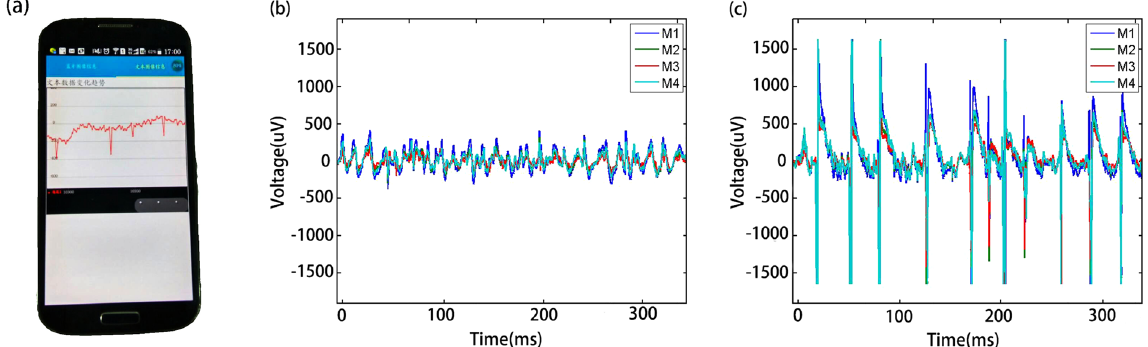
Figure 5. ECoG data show ( a ) in Cell phone, ( b ) and ( c ) in cloud with normal and epilepsy rat.